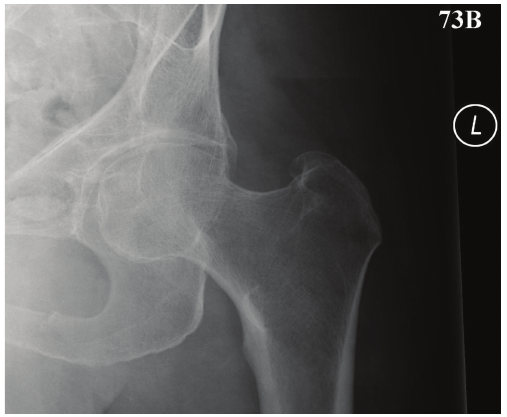
F 2: Example of the Bristol hip view—no